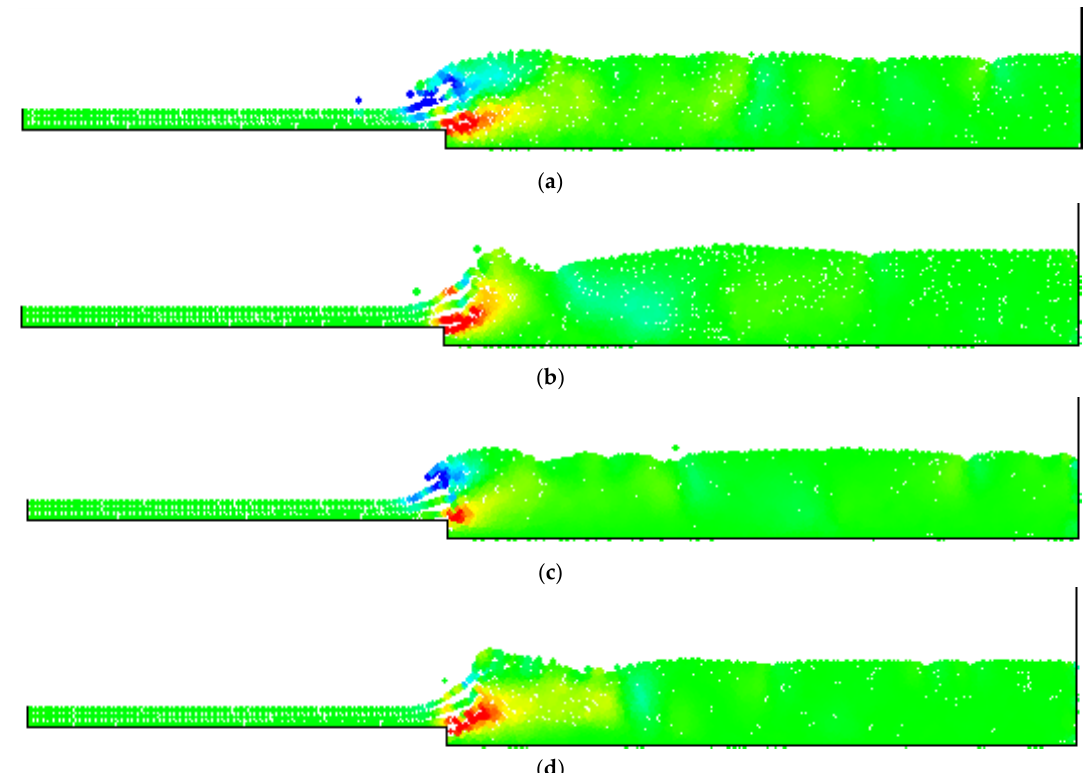
Figure 8. Instantaneous SPH vorticity field in the SPH simulation of Test T1b: ( a ) t = 15 s; ( b ) t = 21 s; ( c ) t = 26 s; and ( d ) t = 30 s. Colour scale is the same as in Figure 7.